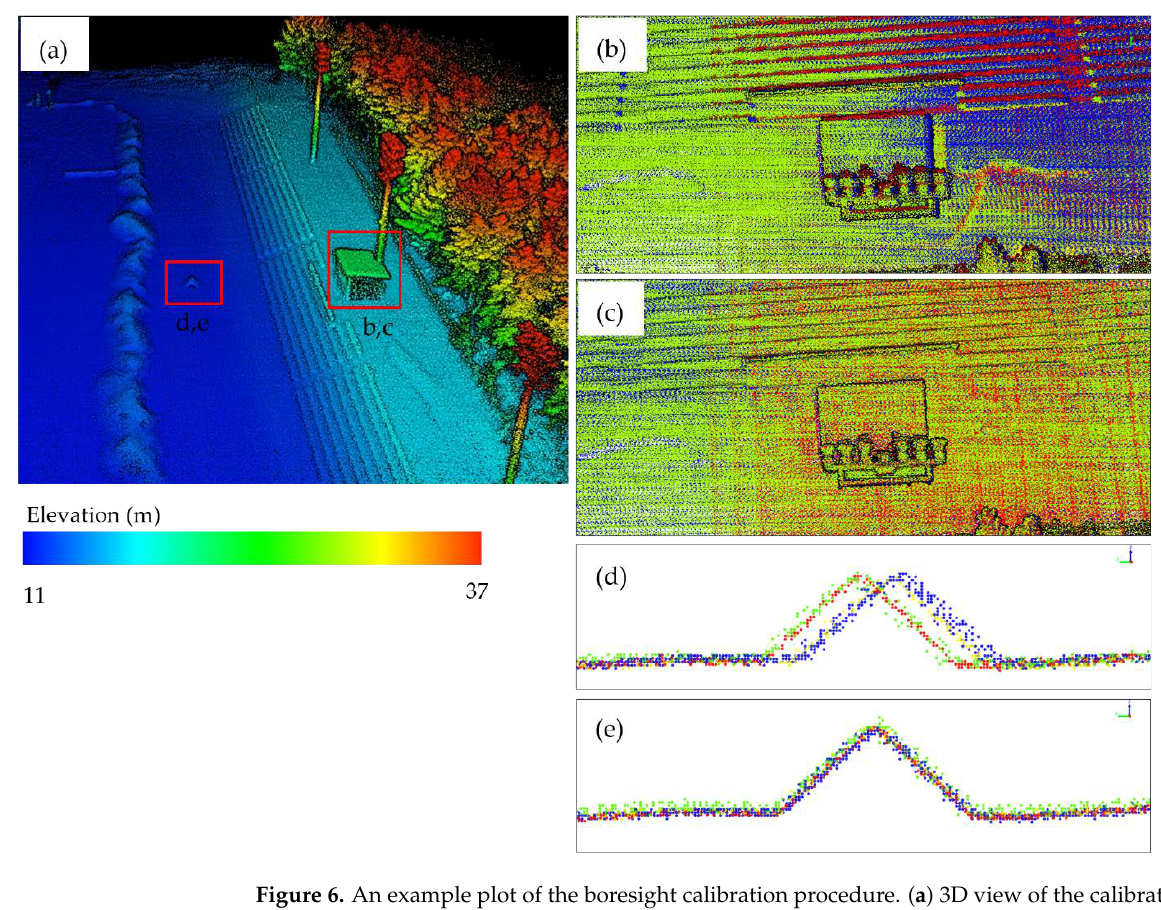
Figure 6. An example plot of the boresight calibration procedure. ( a ) 3D view of the calibration site, lidar point cloud is colorized by elevation (roof structure and inclined surface are demarcated in red squares with relevant letters); ( b ) top view of the roof structure for nominal boresight angles and ( c ) for calibrated boresight angles; ( d ) cross-section view of the inclined surface for nominal boresight angles and ( e ) for calibrated boresight angles. Points scanned from different strips have different colors (red, blue, yellow, and green).